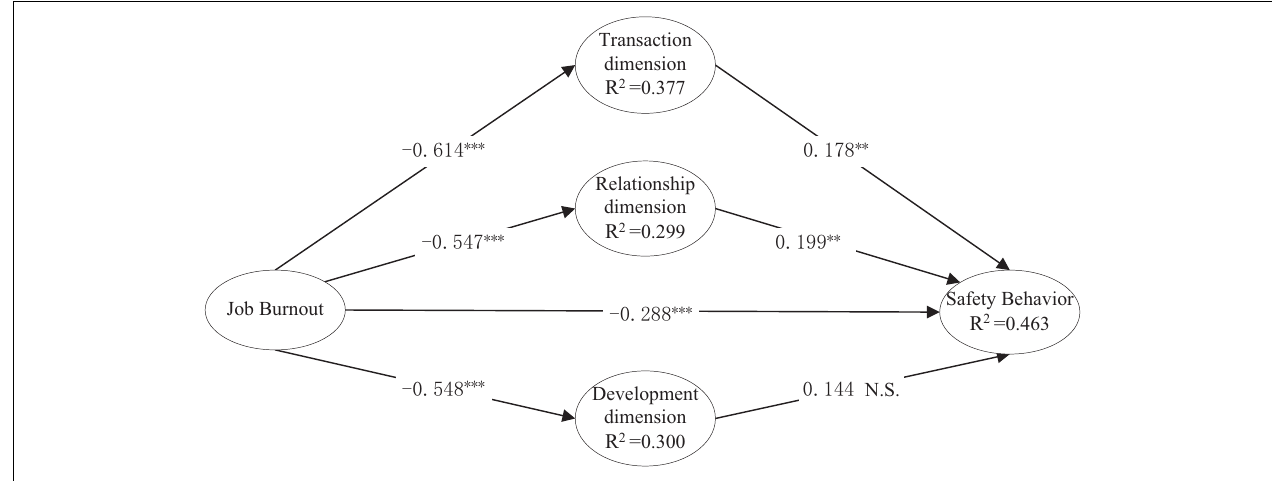
FIGURE 2 | Influence path coefficient. N =353; N.S. is not significant at the significance level of 0.5; ** and ***are significant at the significance level of 0.01 and 0.001, respectively. TABLE 8 | Results of mediating effect ( N = 353). Indirect effect